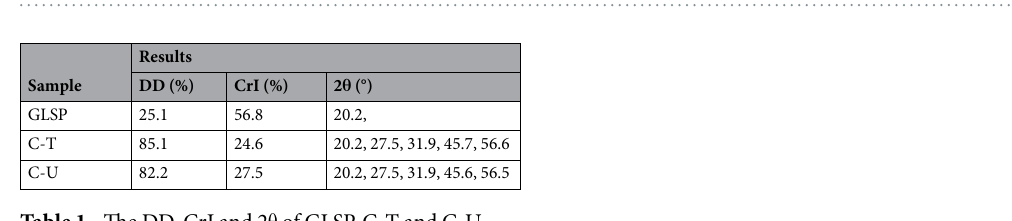
Table 1. The DD, CrI and 2 θ of GLSP, C-T and